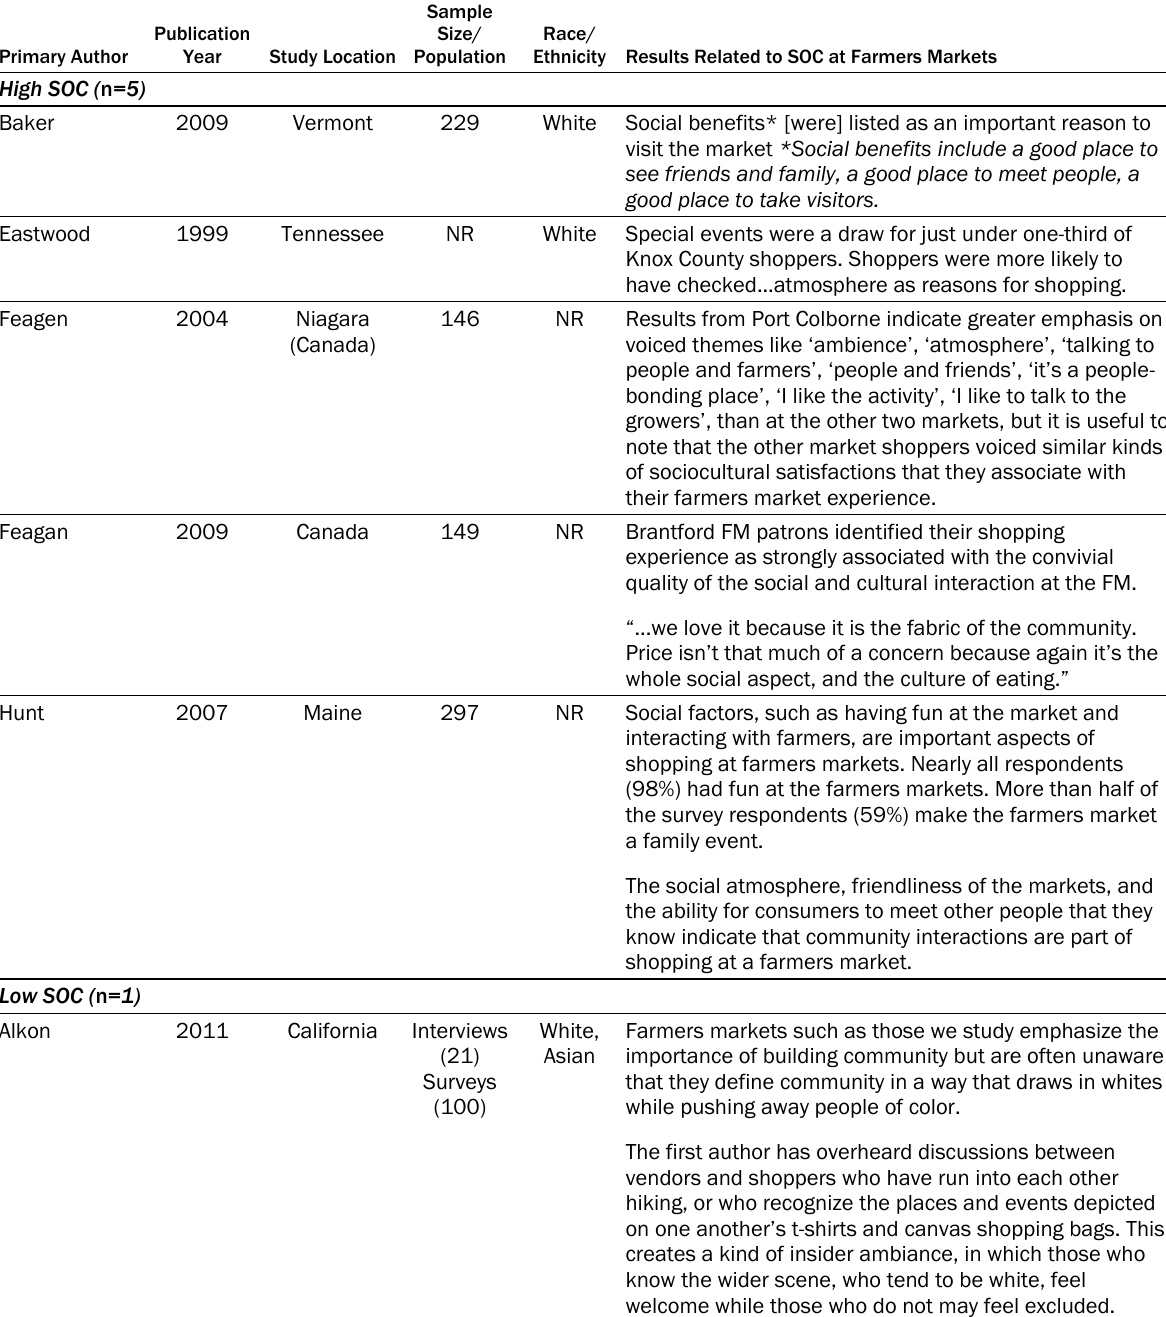
Table 4. Summary of Articles Related to Sense of Community Among Farmers Market (FM) Shoppers Lliving with Middle to High Incomes ( n